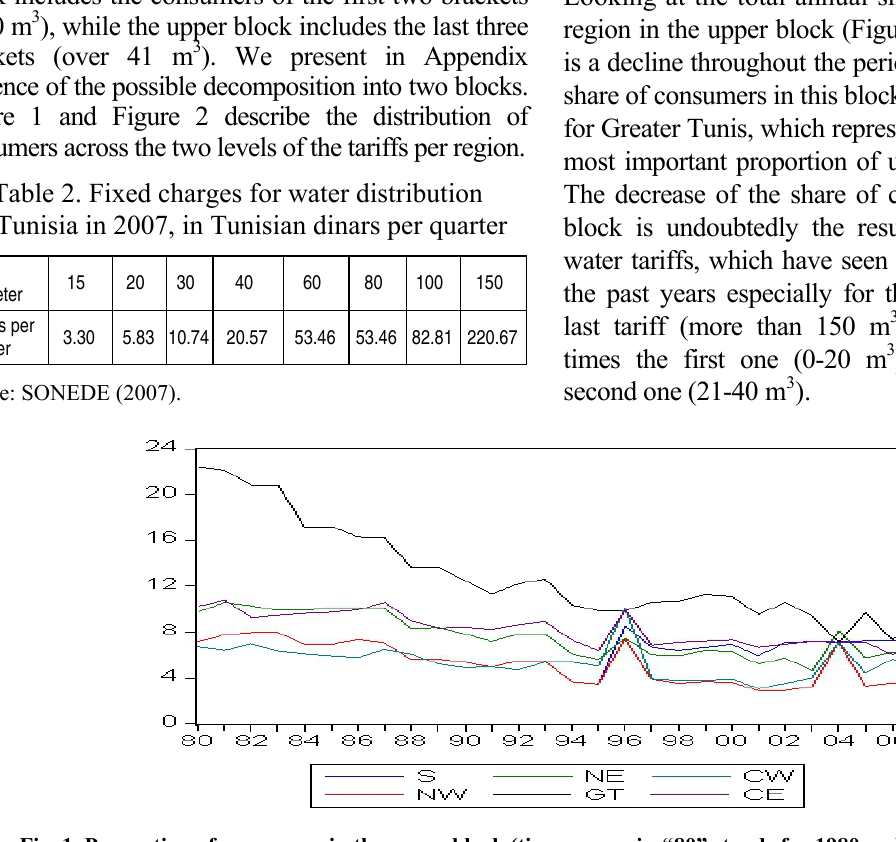
Fig. 1. Proportion of consumers in the upper block (time on x-axis, “80” stands for 1980 and “00” for 2000; % of consumers in the block on the y-axis)